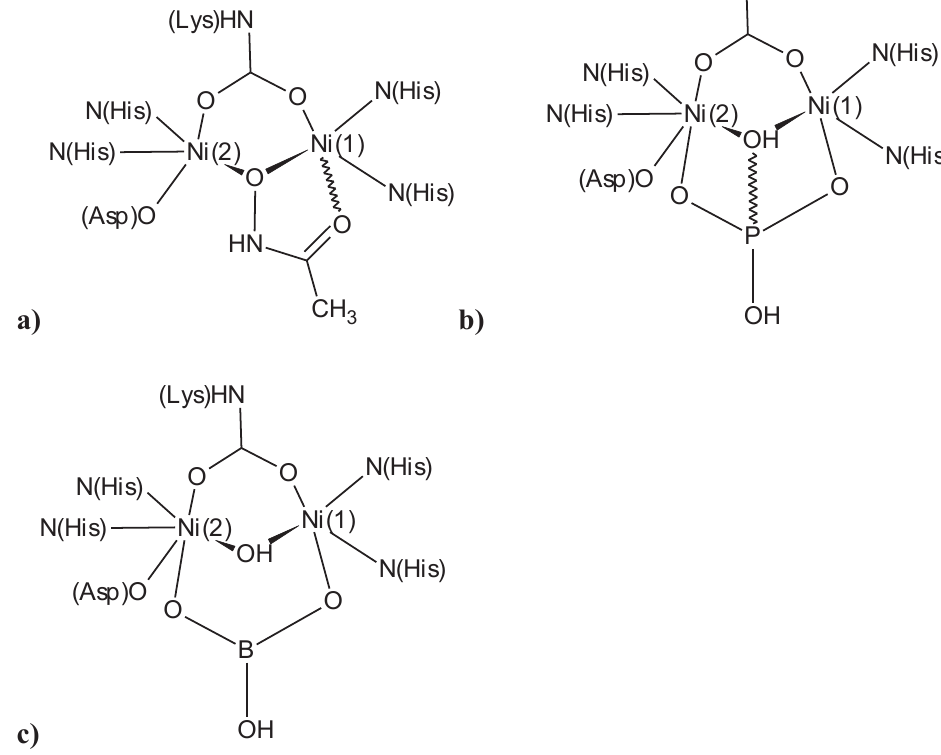
Scheme 3: Formation of Octahedral complexes of HHAQ - with M(II) ions where M = Co, Ni, Cu and Zn.